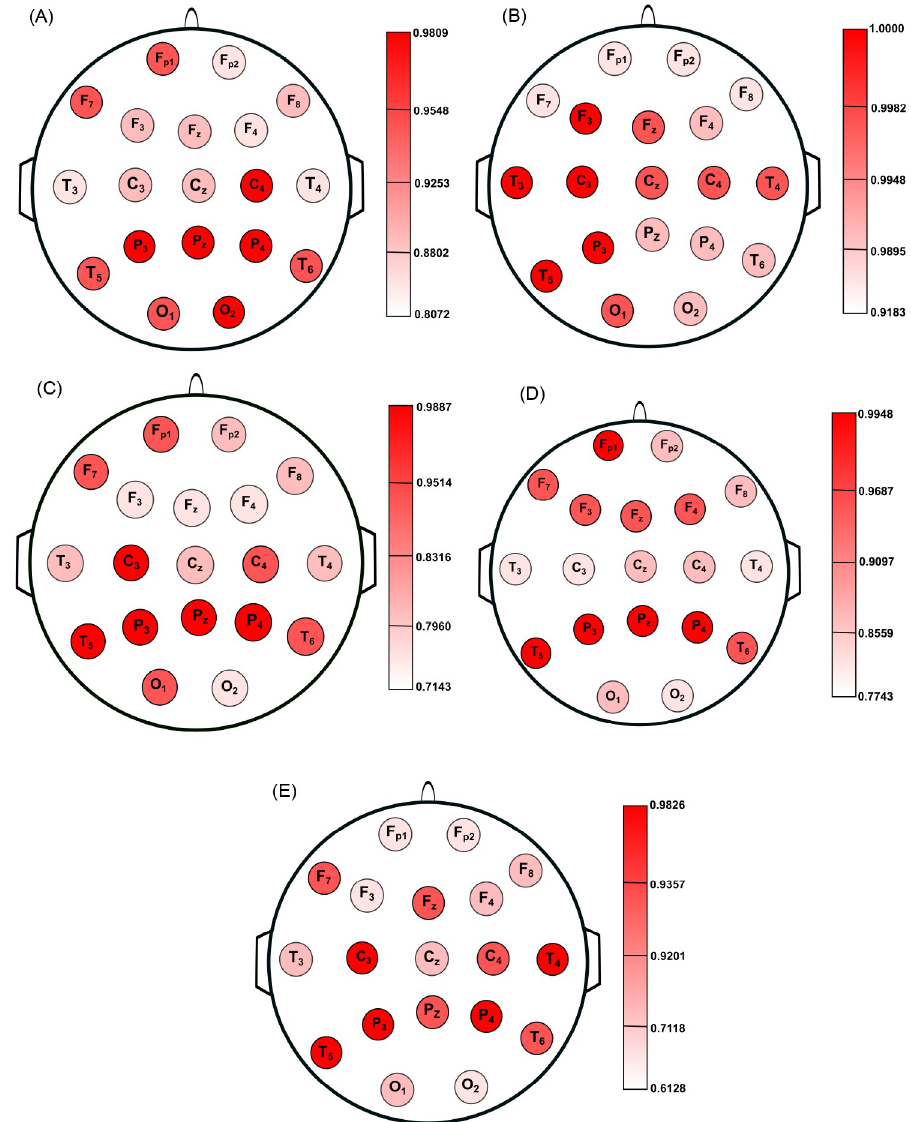
Fig 5. Location on scalp of the 19 EEG channels, represented by circles and colored according to the value of ^ A CC (A), Δ (B), BC (C), Mo (D), and LEE (E), respectively. Circles with darker colors indicate a better differentiation between aging and